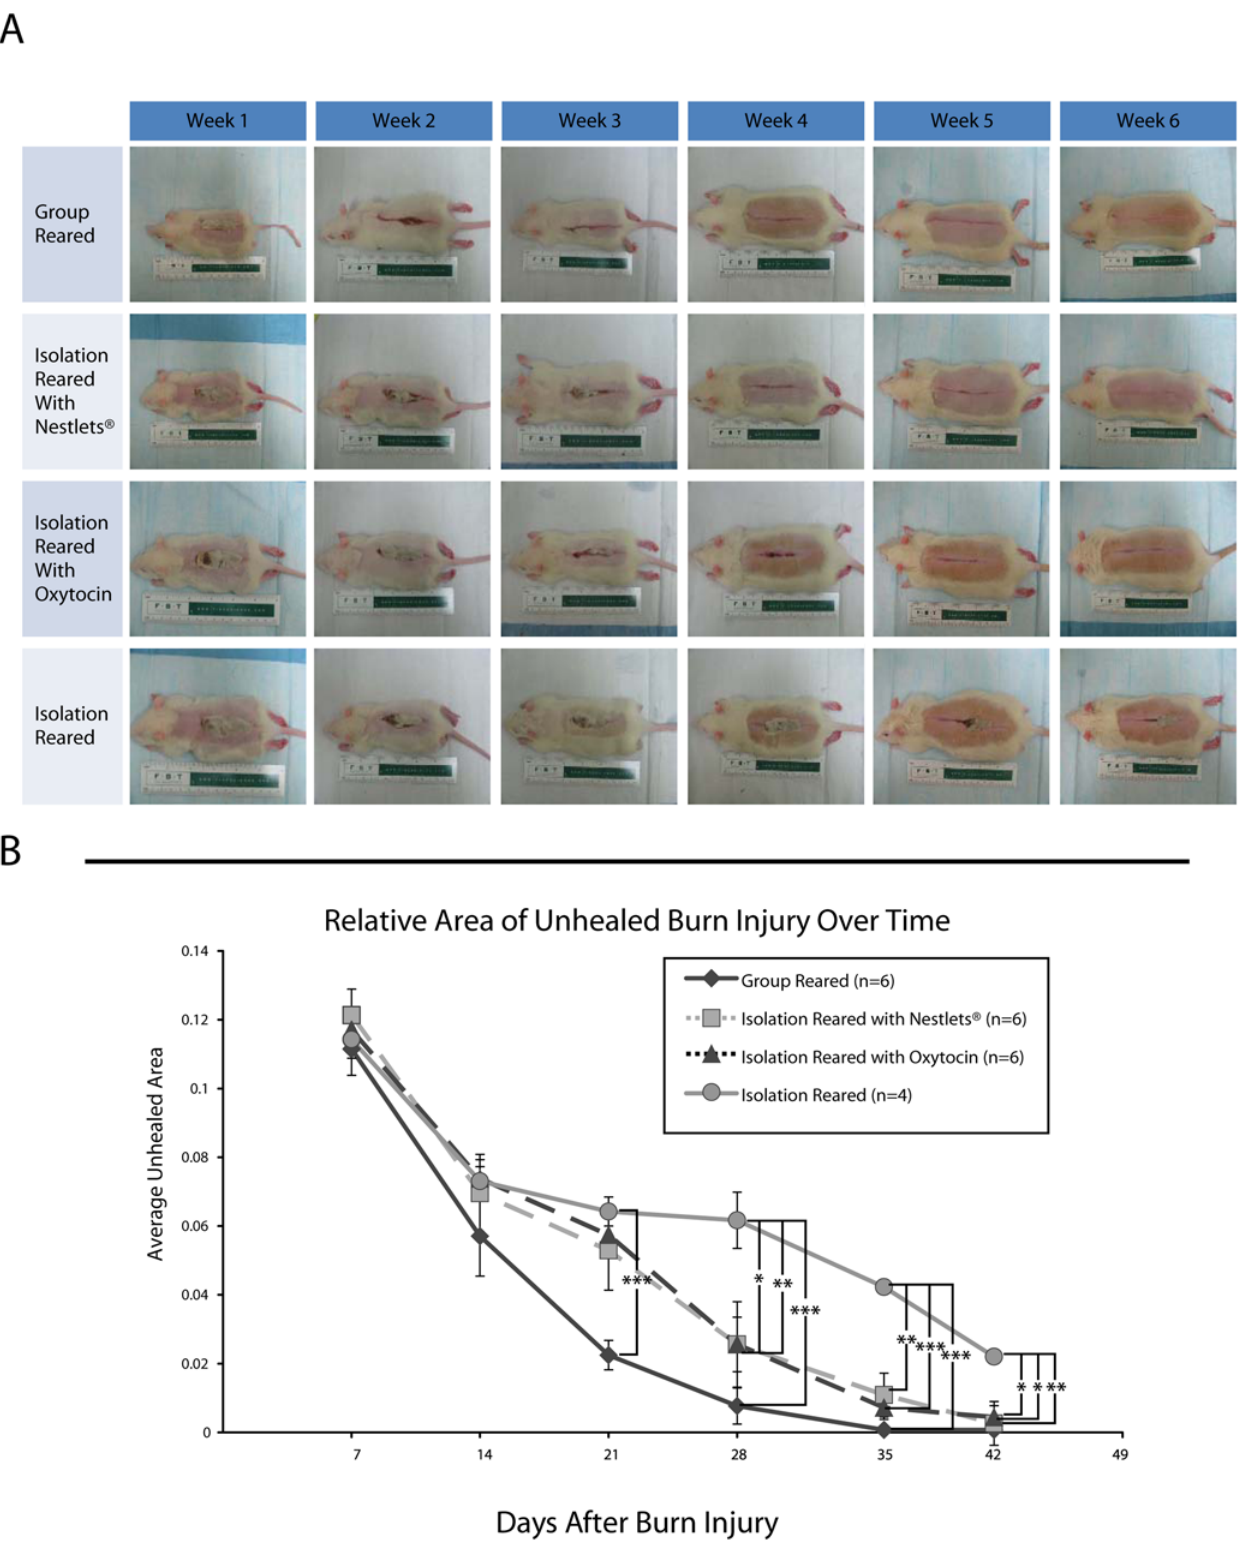
Figure 4. Time series analysis of Nest Building and Oxytocin effect on wound healing. Panel A shows an example of wound healing over six weeks from weaning (PN20 to PN62) in the four conditions examined. Panel B shows that group reared rats had significantly better healing compared to isolation reared rats by 21 days post burn injury, while Nestlet and oxytocin treated rats showed similar healing to group reared rats by 28 days post burn injury. The difference between Nestlet treated, oxytocin treated, and group reared rats compared to isolation reared rats continued until 42 days post burn injury. Average 6 S.E.M., *p , .05, ** p , 0.01, ***p , 0.001.